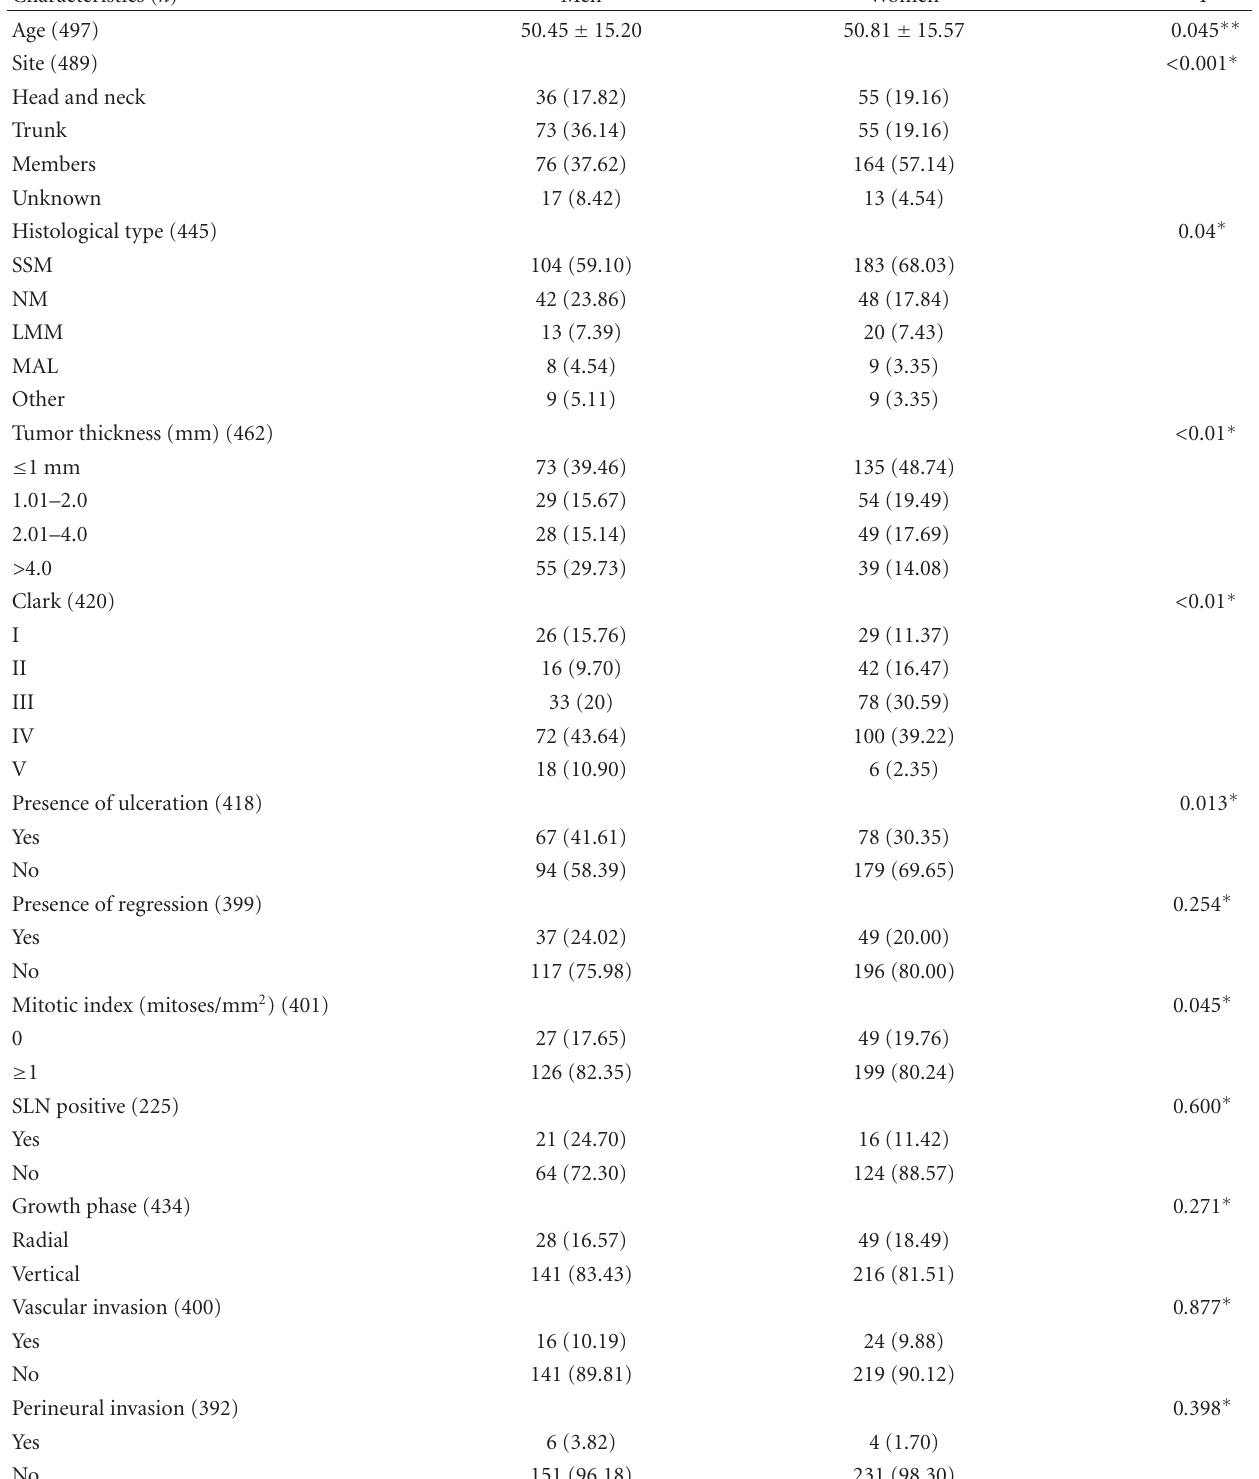
Table 2: Clinical and histopathological characteristics of patients with cutaneous melanoma in the western region of Santa Catarina, Brazil, classified by